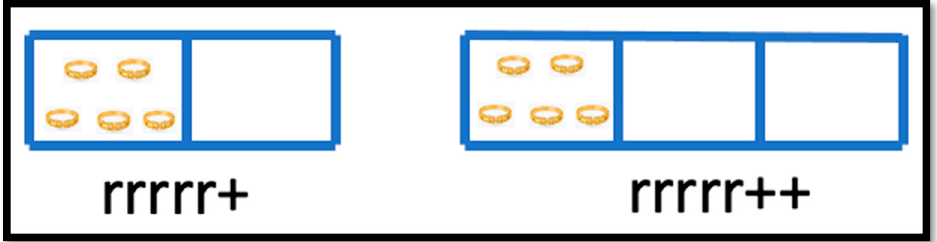
Figure 7. Finger rings in partitioned boxes and their symbolic representations.